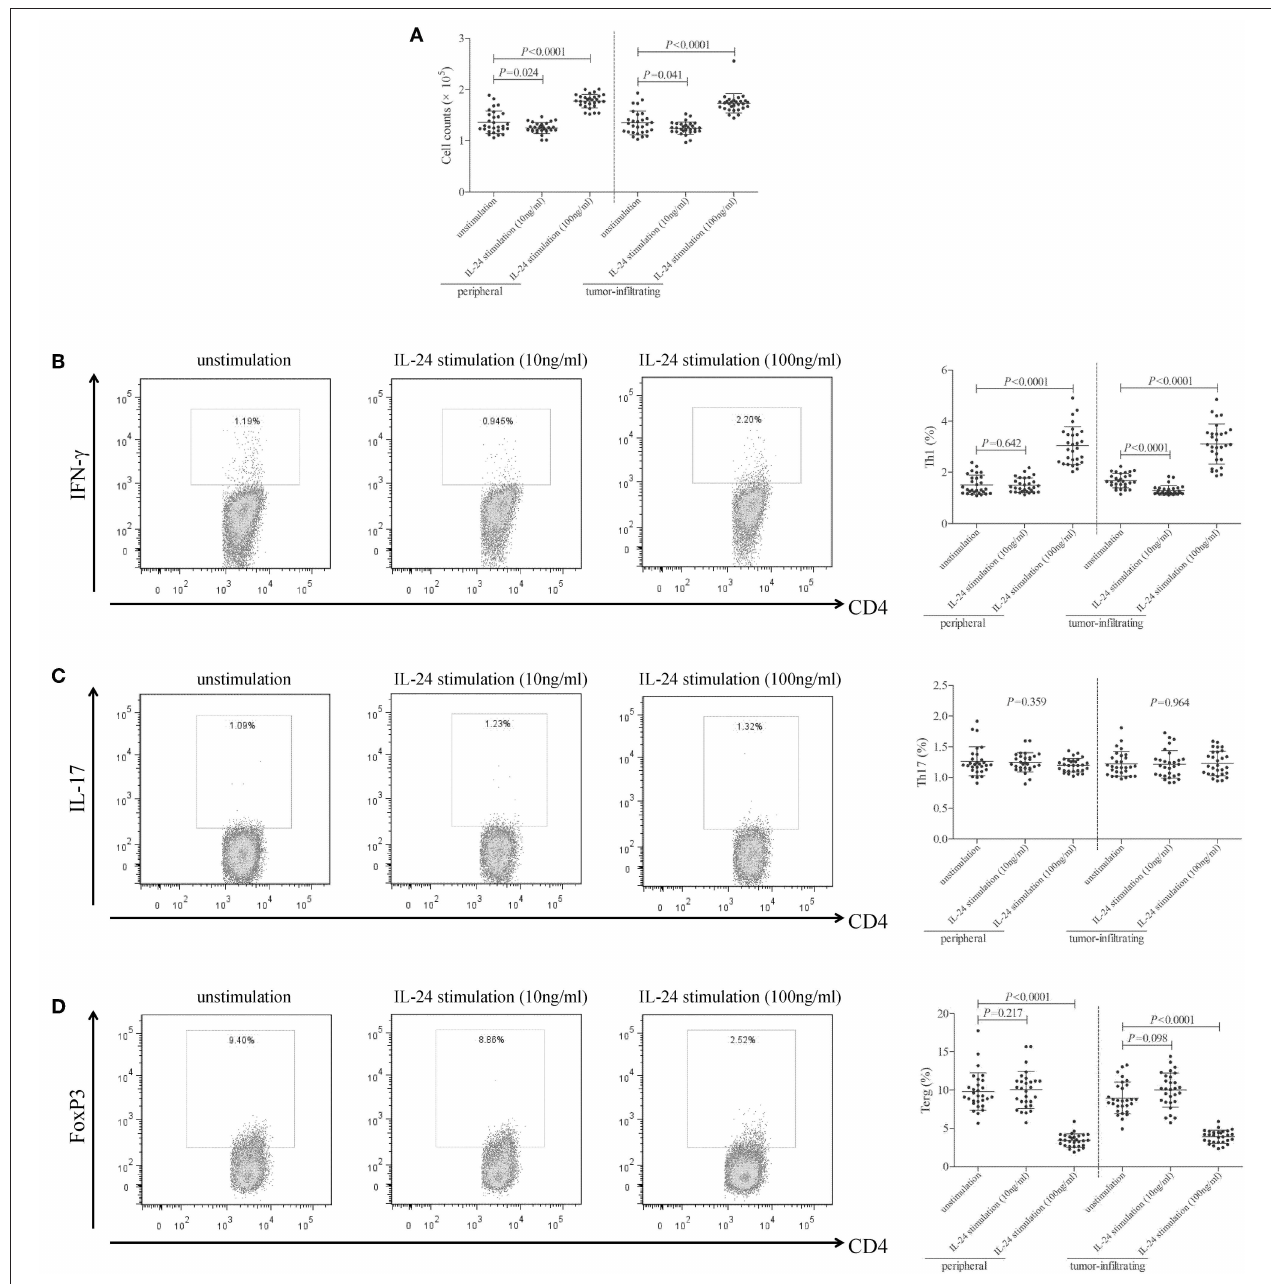
FIGURE 3 | Influence of recombinant IL-24 stimulation on peripheral and tumor-infiltrating CD4 + T cell activity in colorectal adenocarcinoma. 10 5 of purified CD4 + T cells from colorectal adenocarcinoma patients ( n = 29) were stimulated with low concentration (10ng/ml) or high concentration (100ng/ml) of recombinant human IL-24 for 24h. (A) Cellular proliferation was measured by CCK-8, and was compared among groups (One-way ANOVA, P < 0.0001). (B) Representative flow dots of CD4 + IFN- γ + Th1 cells were shown in unstimulated, 10ng/ml of IL-24 stimulated, and 100ng/ml of IL-24 stimulated cells. Percentage of Th1 cells was compared among groups (One-way ANOVA, P < 0.0001). (C) Representative flow dots of CD4 + IL-17 + Th17 cells were shown in unstimulated, 10ng/ml of IL-24 stimulated, and 100ng/ml of IL-24 stimulated cells. Percentage of Th17 cells was compared among groups (One-way ANOVA, P > 0.05). (D) Representative flow dots of CD4 + FoxP3 + Treg were shown in unstimulated, 10ng/ml of IL-24 stimulated, and 100ng/ml of IL-24 stimulated cells (One-way ANOVA, P < 0.0001). Percentage of Treg was compared among groups. Individual level of each subject was shown. One-way ANOVA and Tukey test for multiple comparison was used for comparison.